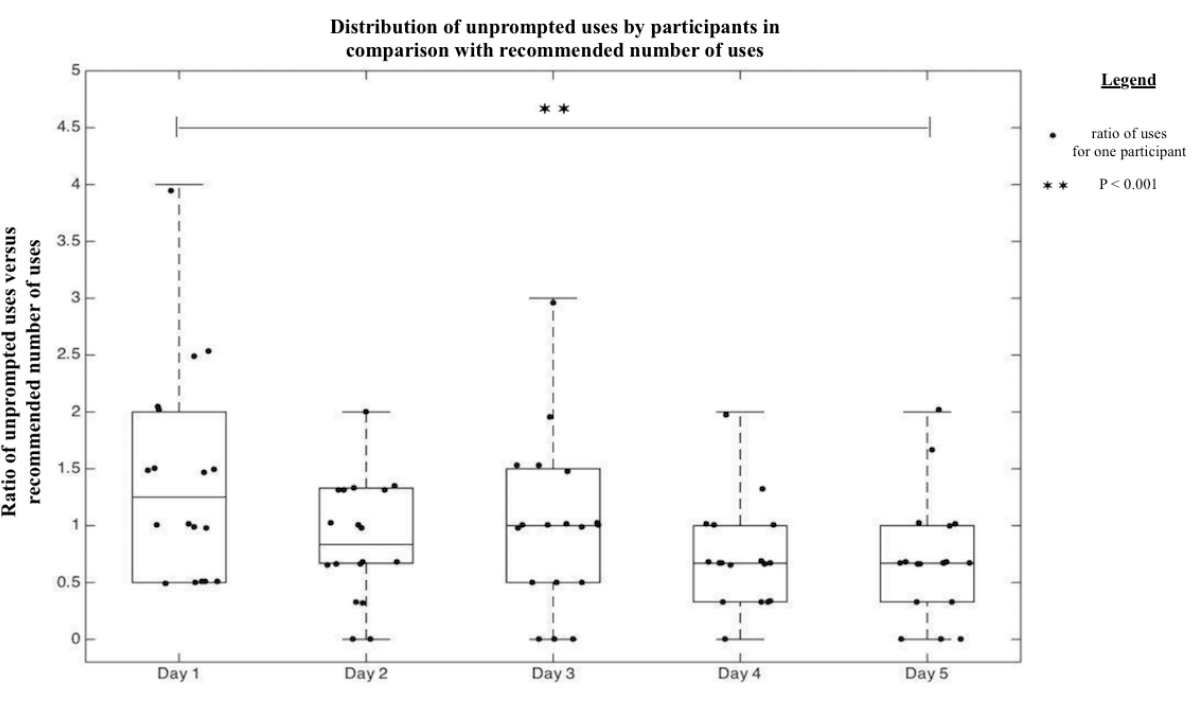
Figure 5. Box and whiskers plot of normalized unprompted uses expressed as a ratio of unprompted uses and expected number of uses. For example, on day 1, mothers on average used NeMo 1.25 times more than expected. Each point represents the ratio of uses by one participant on a corresponding day. Expected number of unprompted uses was 2 times on days 1 and 3 and 3 times on days 2, 4, and 5.